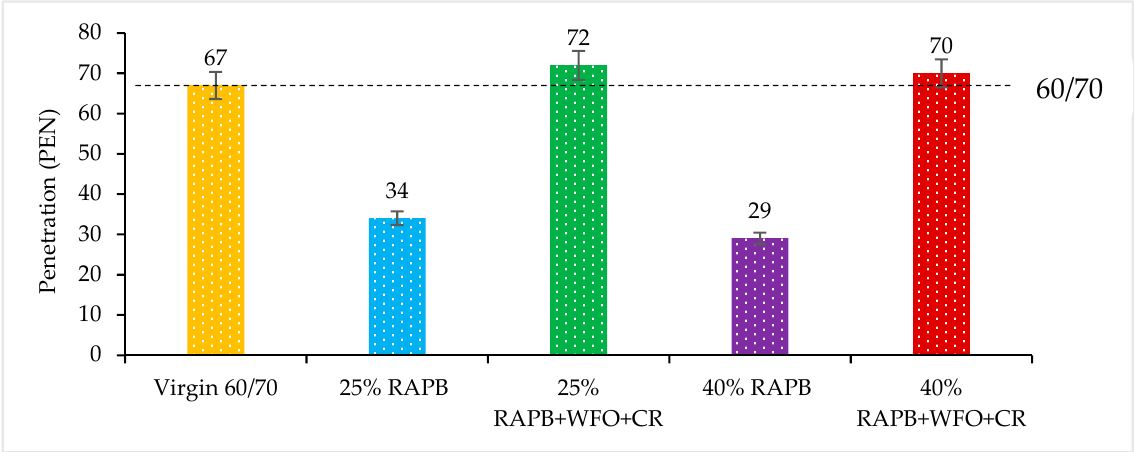
Figure 2. Penetration results at 25 °C for all binders.